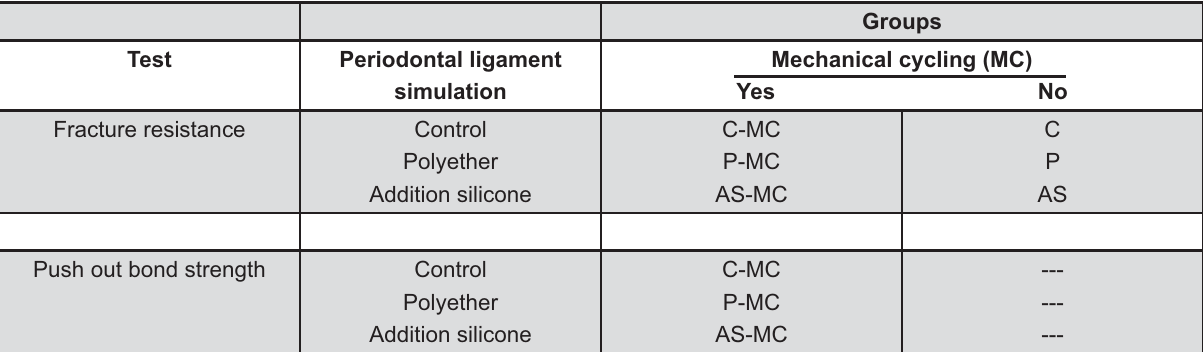
Figure 1- Experimental